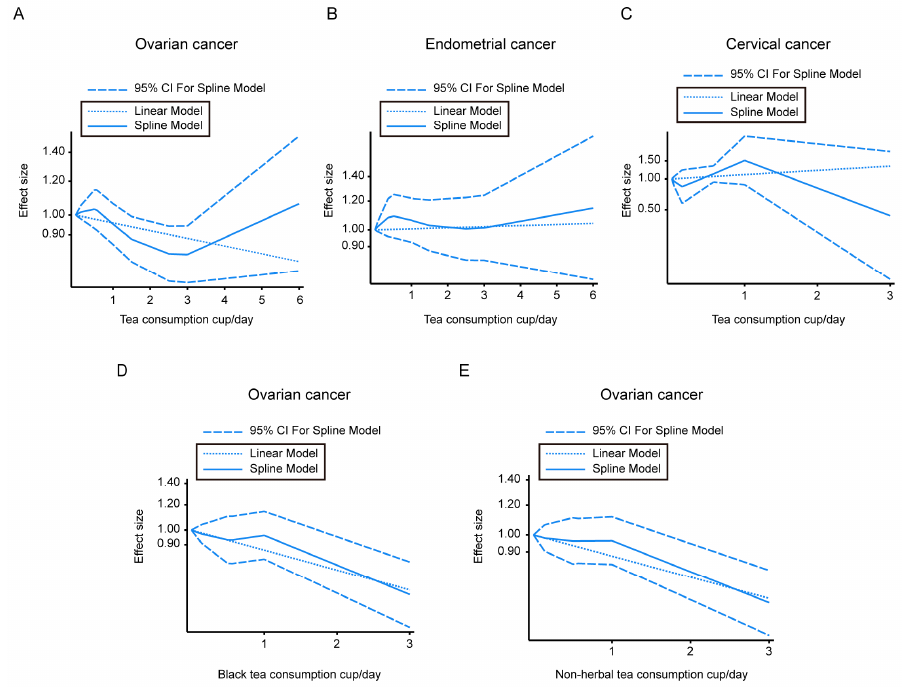
Figure 3. Dose–response correlation between different types of tea consumption and gynecologic cancer morbidity. ( A – C ) Dose–response analysis of tea intake and ovarian tumor morbidity ( A ), or endometrial tumor morbidity ( B ), or cervical tumor morbidity ( C ). ( D ) Dose–response analysis of black tea consumption and ovarian tumor morbidity. ( E ) Dose–response analysis of non-herbal tea consumption and ovarian tumor morbidity. CI—confidence intervals.